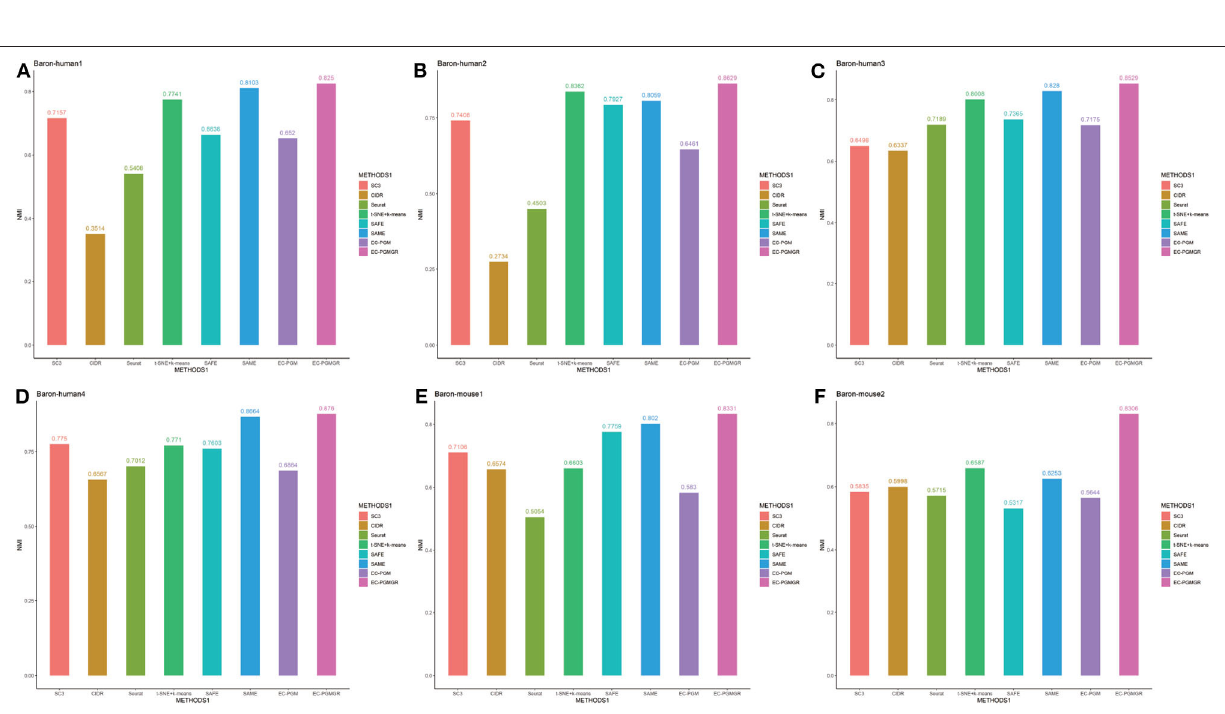
FIGURE 6 | Performance on different data sets with different methods in term of NMI. SC3, CIDR, Seurat and t-SNE+k-means are the individual methods, while SAFE, SAME, EC-PGM and EC-PGMGR are the ensemble clustering methods. (A) Baron-human1. (B) Baron-human2. (C) Baron-human3. (D) Baron-human4. (E) Baron-mouse1. (F)